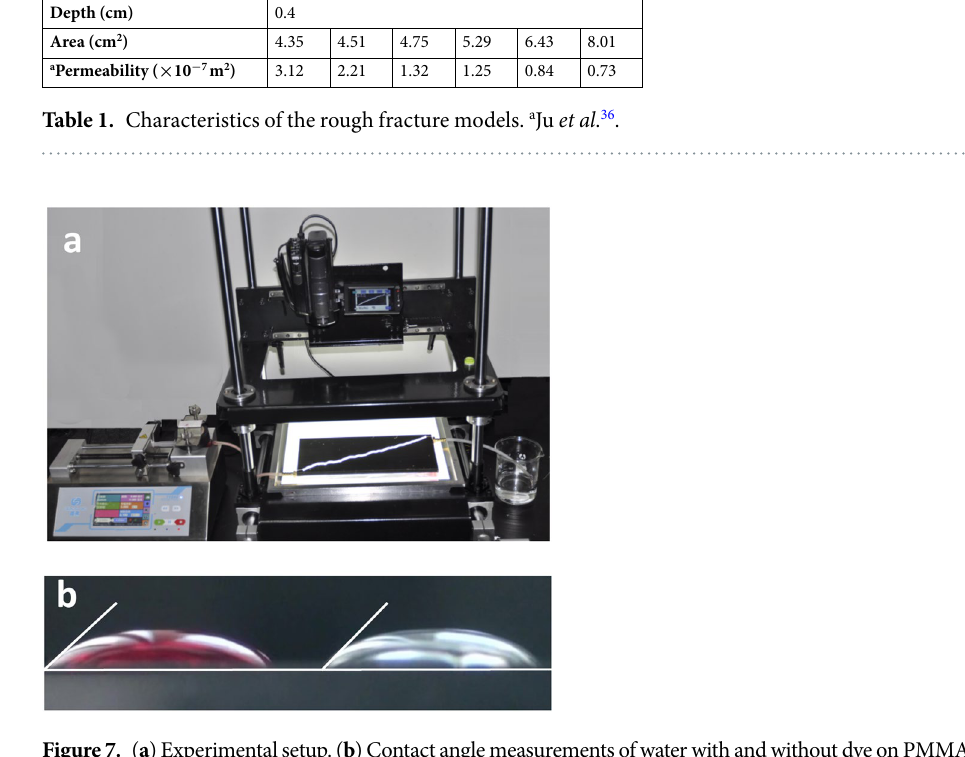
Figure 7. ( a ) Experimental setup. ( b ) Contact angle measurements of water with and without dye on PMMA